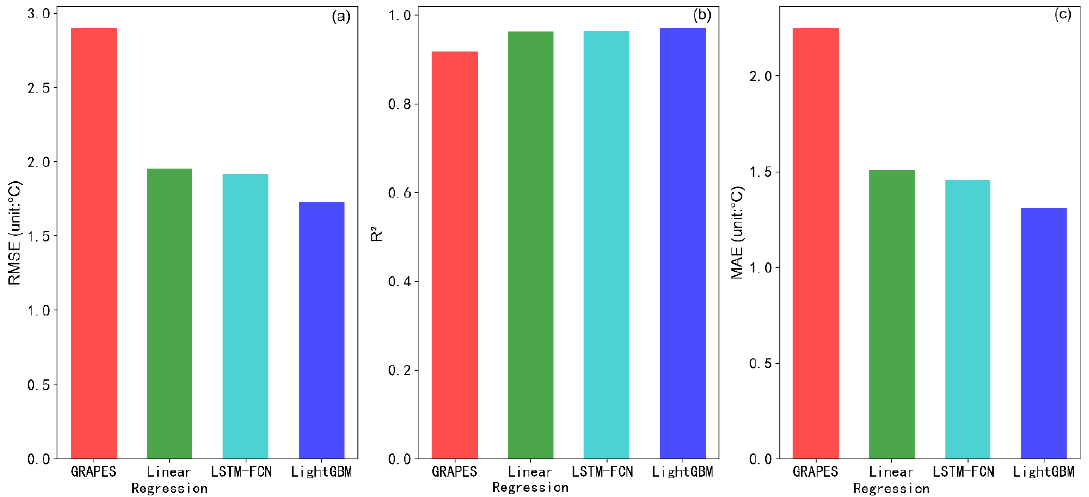
Figure 4. Averaged RMSE ( a ), R 2 ( b ) and MAE ( c ) values of the GRAPES-3km model and the three correction methods.